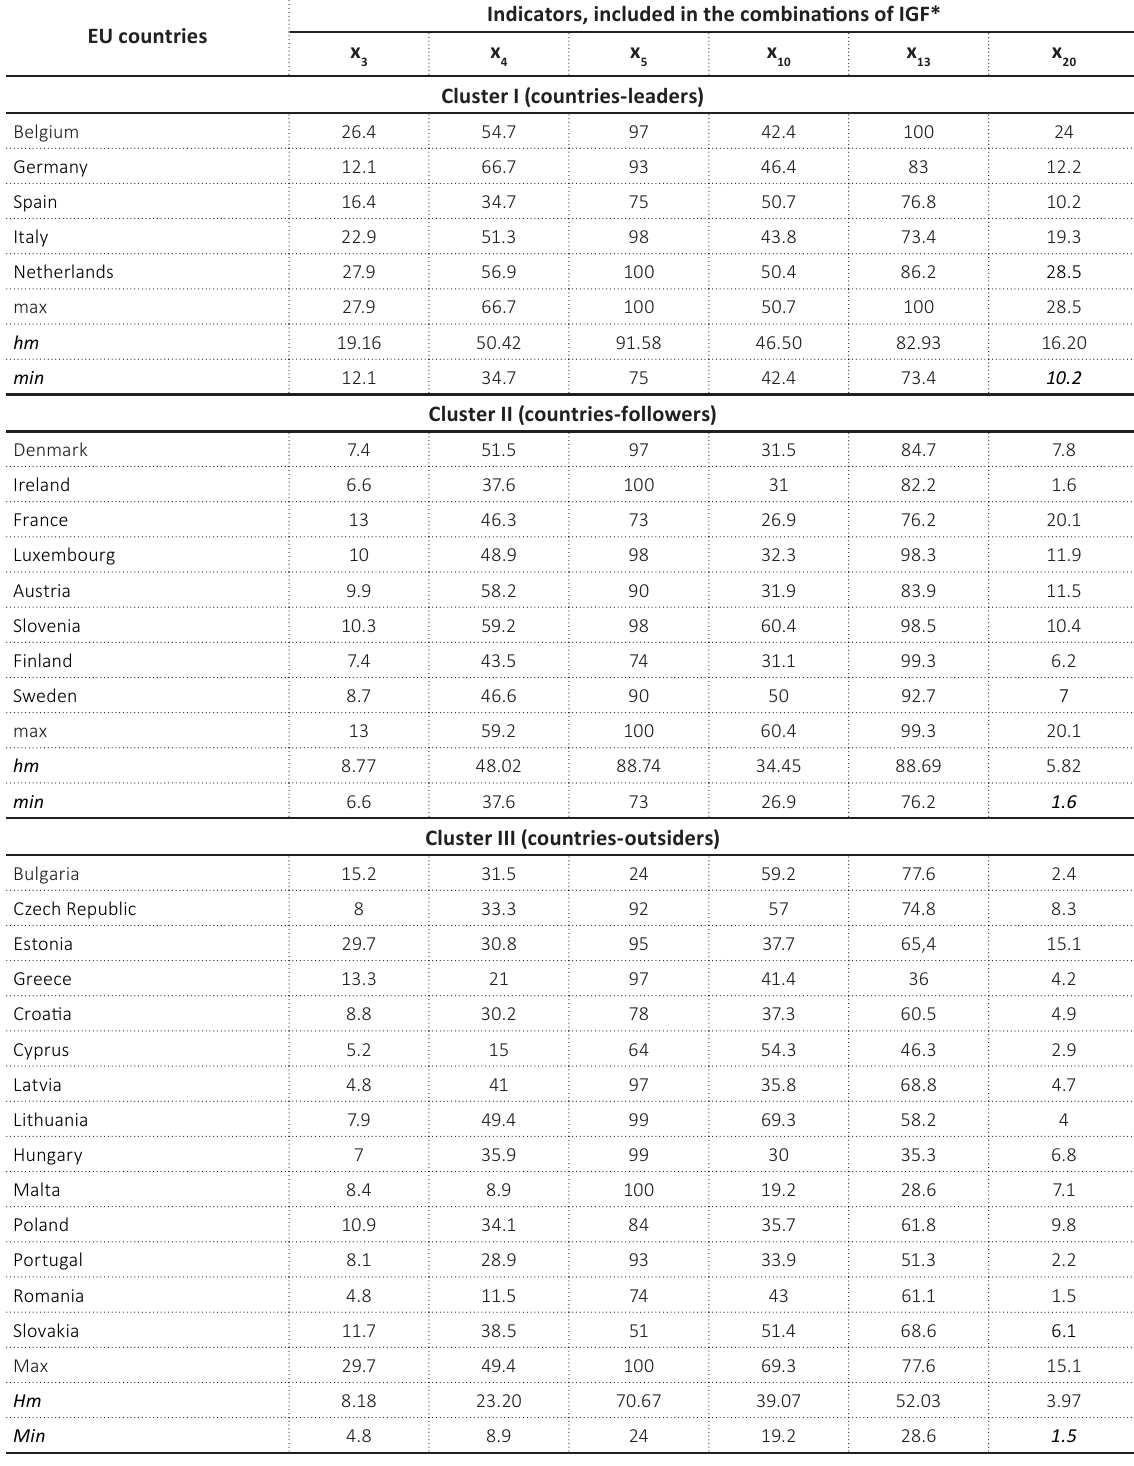
Table 4. Results of parametric analysis by the indicators included in the combinations, which separate the clusters of the EU countries EU countries